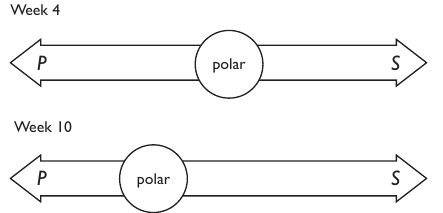
FIG. 8. A comparison of the plasticity of Derek’s polar resource in weeks 4 and 10. In week 4, there was insufficient evidence to know how plastic polar is (cid:1) only that it is more solid than Wes’s (cid:2) . In week 10, Derek’s derivation details indicate that it